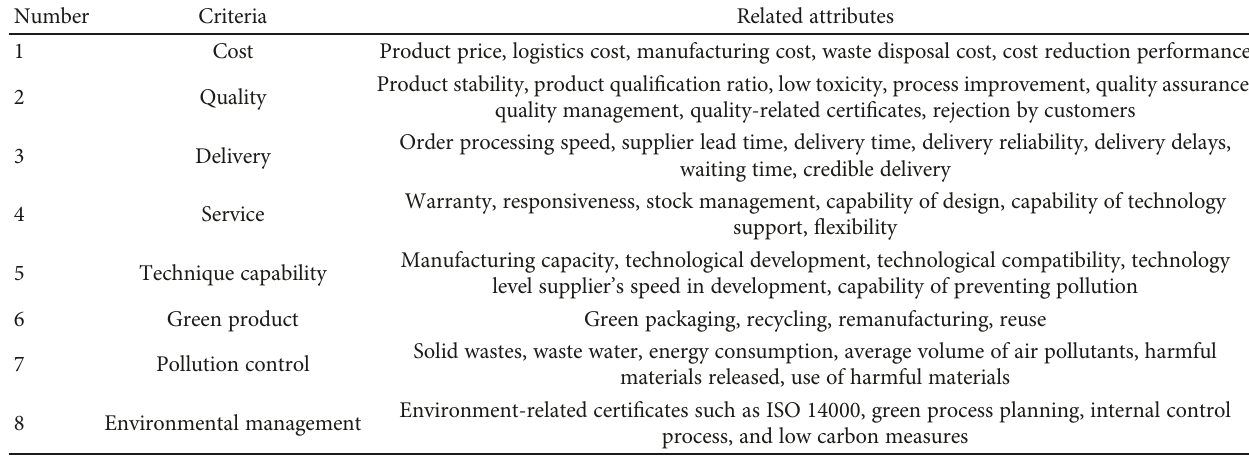
Table 1: Green supplier selection